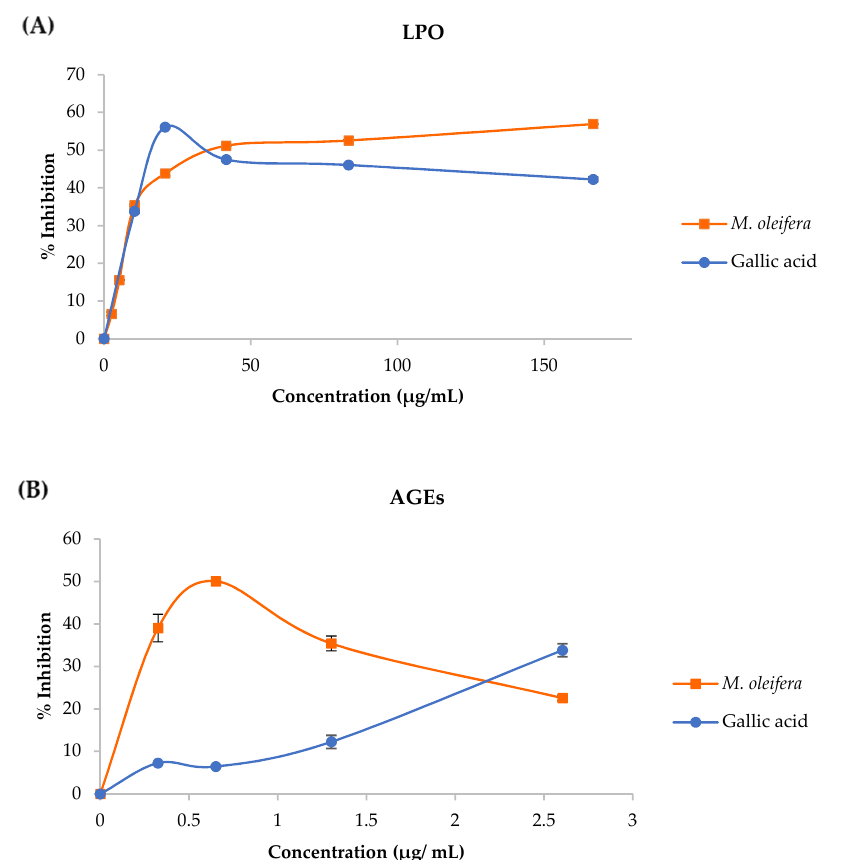
Figure 2 . Percent inhibition of DPPH ( A ) , ABTS ( B ) , and H 2 O 2 ( C ) of M . oleifera leaf tea . Data are mean values ± standard error ( error bars ) .